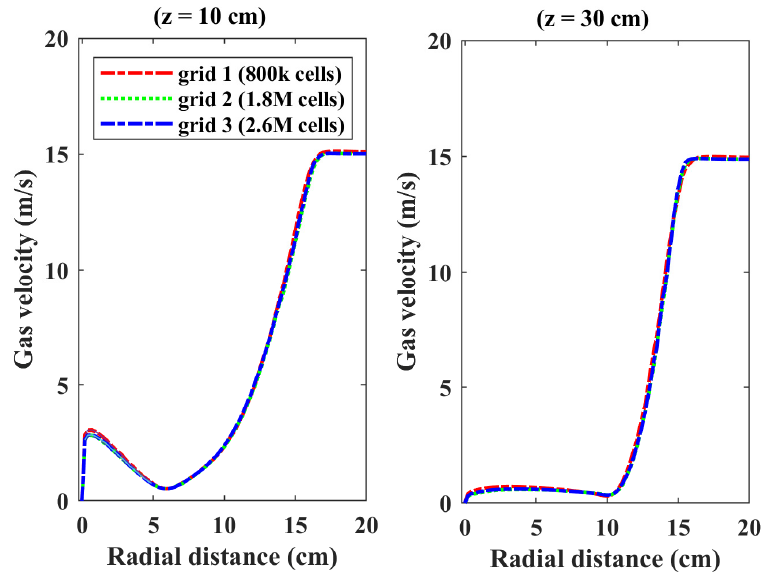
Figure 2. Comparison of gas velocity at two axial locations for grid independency study .